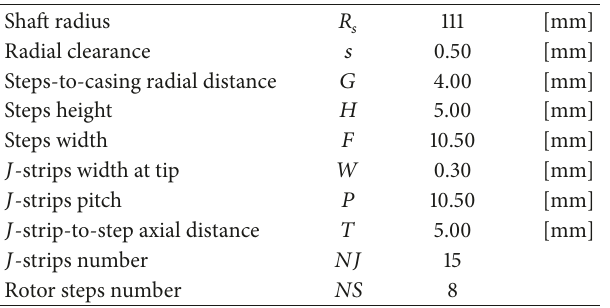
Table 5: Geometry parameters of the seal used in the experimental tests.